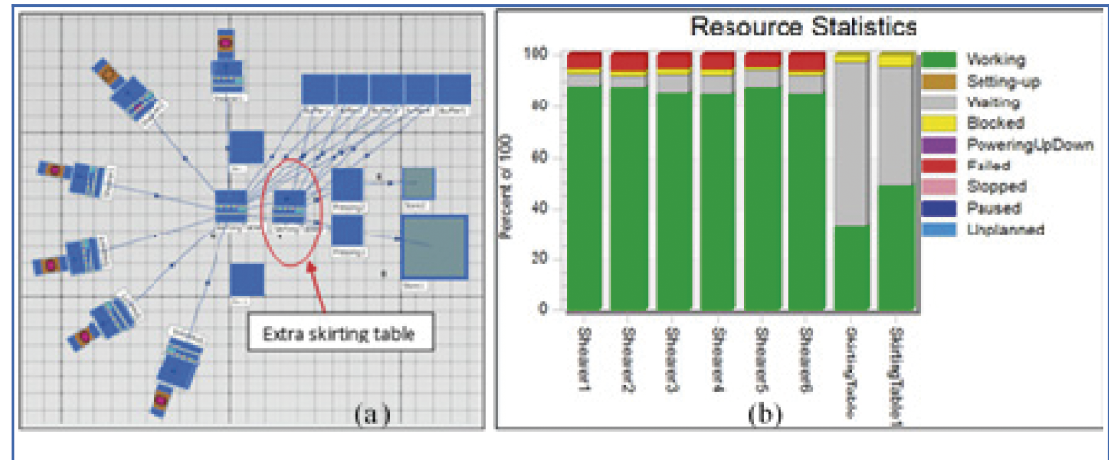
Figure 8. Plant Simulation model showing the curved wool shed layout